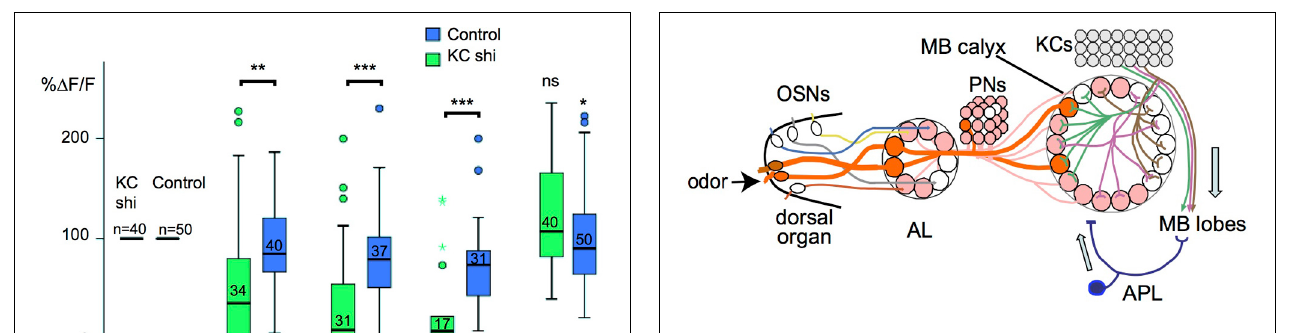
FIGURE 6 | Model of larval olfactory pathway with feedback inhibition in the mushroom body. Single olfactory sensory neurons (OSNs) project to single antennal lobe (AL) glomeruli, from where single projection neurons (PNs) project mostly to single glomeruli in the mushroom body (MB) calyx. Odors normally activate multiple OSNs and hence multiple PNs and calyx glomeruli (two examples shown in orange and thick lines). If enough dendritic branches of an individual Kenyon cell (KC) are activated by inputs from multiple calyx glomeruli, the KC transmits signals to the MB lobes. The APL responds to KC activity in the MB lobes and transmits an inhibitory feedback signal (GABA) to the MB input region in the calyx. Adapted from Masuda-Nakagawa et al.